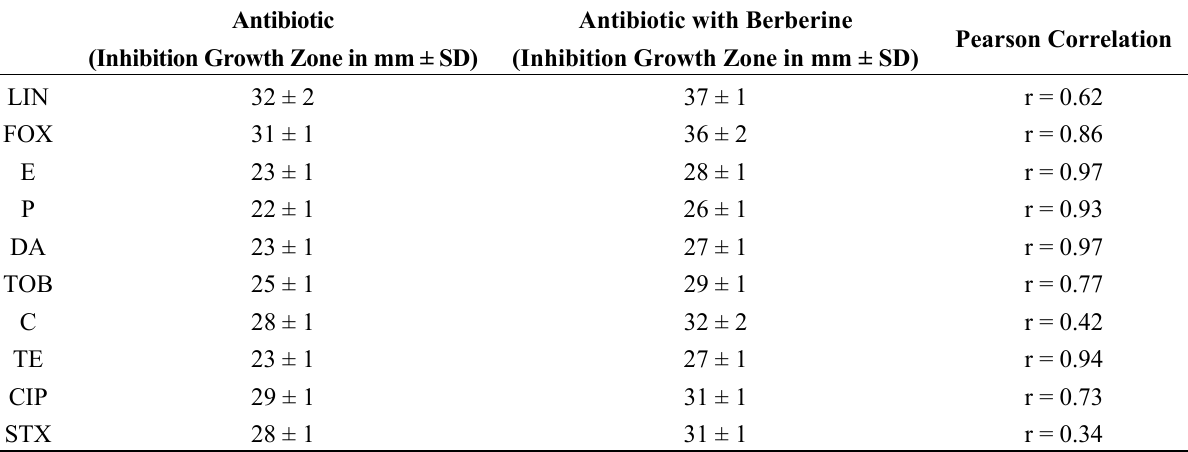
Table 4. Alteration of inhibition growth zone investigated antibiotics in combination with berberine for CoNS strains. Pearson Correlation p =